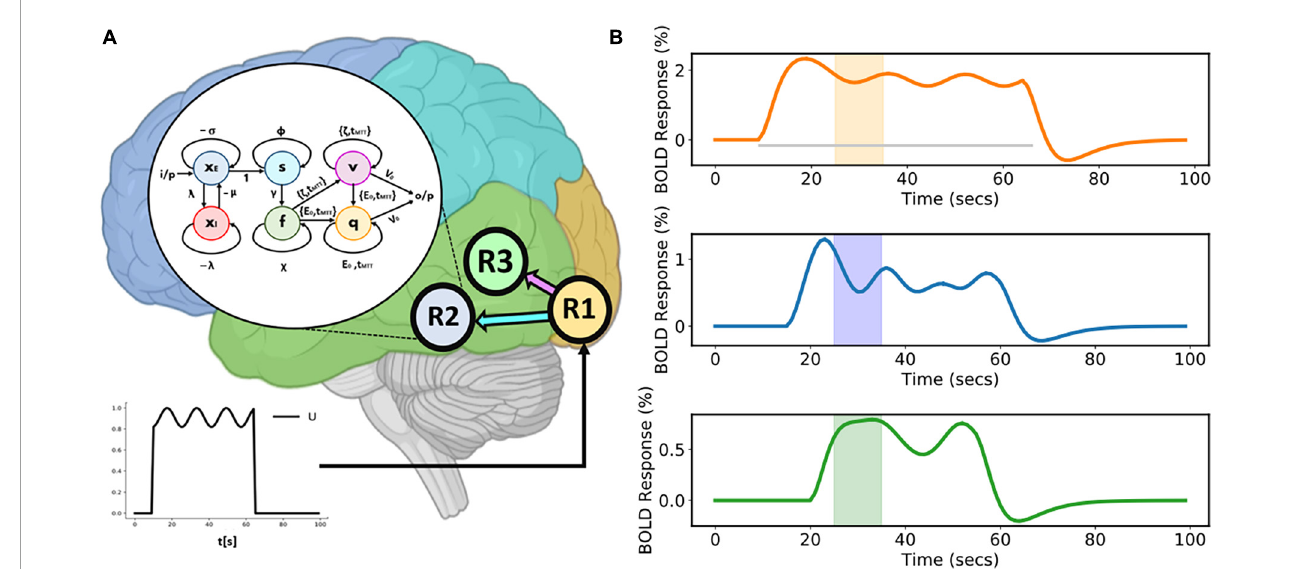
FIGURE3 Three-region model and corresponding area-specific simulated functional magnetic resonance imaging (fMRI) blood oxygenation level-dependent (BOLD) responses. (A) Three-region model for which connections exist from Region 1 (R1) to Region 2 (R2) and from Region 1 (R1) to Region 3 (R3). The sinusoidal input u is applied to R1 and then activity propagates to both R2 and R3. The model inside the white circle (with black border) shows the internal sample model representation of R2. (B) Corresponding area-specific simulated fluctuating fMRI BOLD time courses with windows centered at the 30th second. The gray horizontal line represents the duration of the input stimulus.